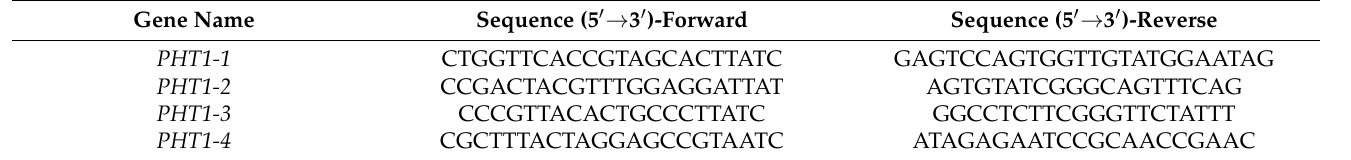
Table 2. Sequences of qRT-PCR primers for PHT1-1 , PHT1-2 , PHT1-3 , and PHT1-4 .